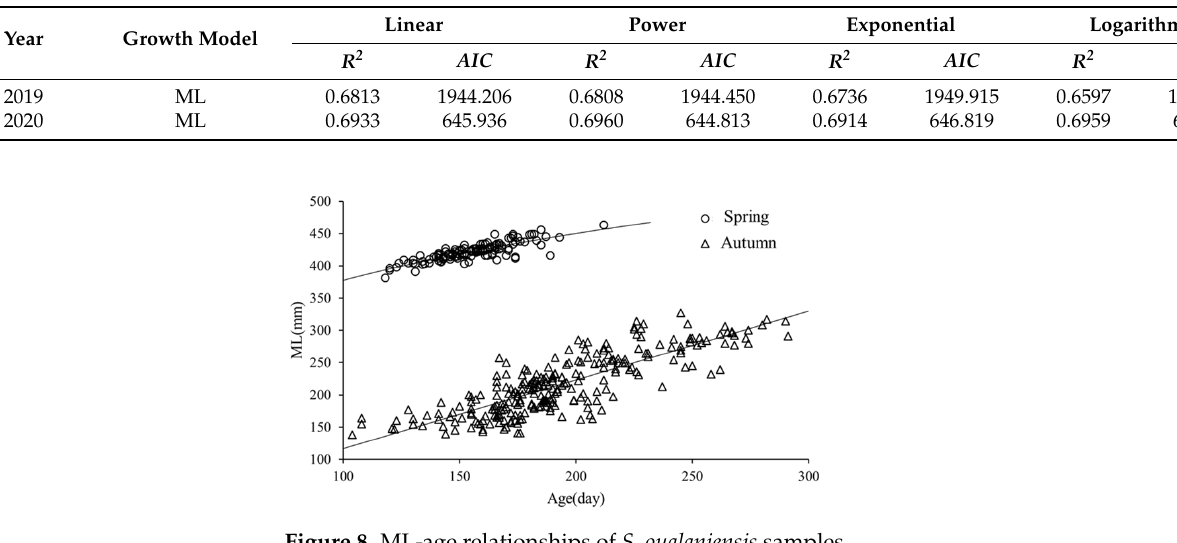
Table 2. Parameters of the linear, power, exponential, and logarithmic growth models fitted to the ML-age relationships of the S. oualaniensis samples.